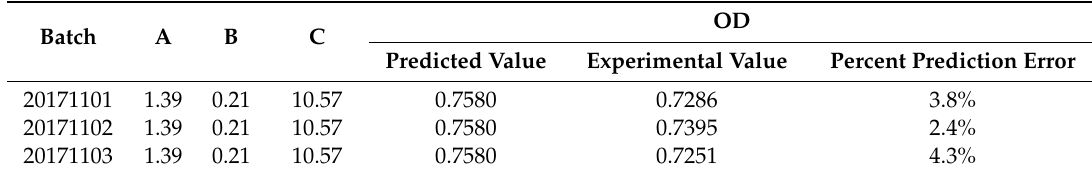
Table 6. The experimental and values for response (OD) along with percentage prediction error observed for the optimum test conditions. Batch